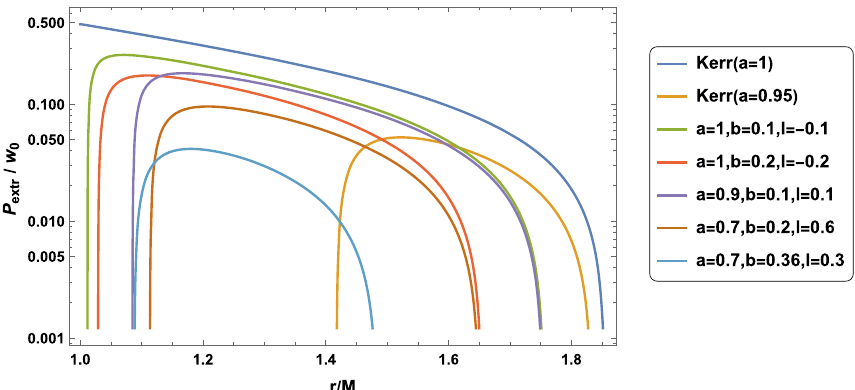
Fig. 3 Extracted power via magnetic reconnection per unit enthalpy as function of the X-point position, with ξ = π/ 12 and σ = 10, for several set of parameters. The trends do not change much as σ 0 increases directedtowardsthe(outer)eventhorizon.Becauseofenergy conservation, the “theft” of rotational energy is equal to